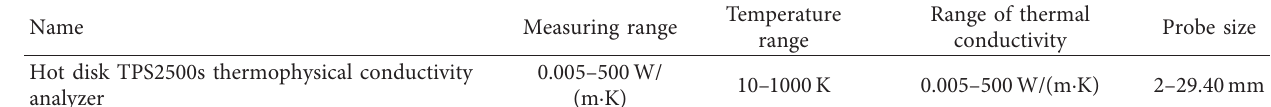
Table 3: Parameters of the thermophysical property analyzer.